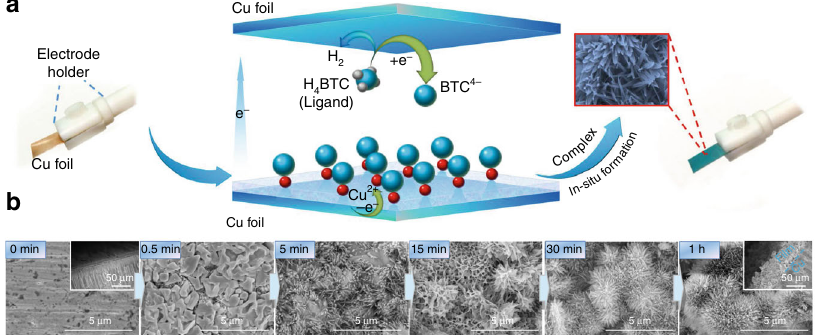
Fig. 1 In situ anodic electrodeposition of copper complex on copper foil. a Schematic illustration of the process to prepare Cu-Complex-1 fi lm on Cu substrate. H 4 BTC = pyromellic acid, BTC 4 − = tetraanion of pyromellitic acid; b SEM images of Complex-1 formed on Cu substrate at electrodeposition times of 0, 0.5, 5, 15, 30, 60 min. The side-view of the fi lm obtained at 60 min is also given in the fi gure as